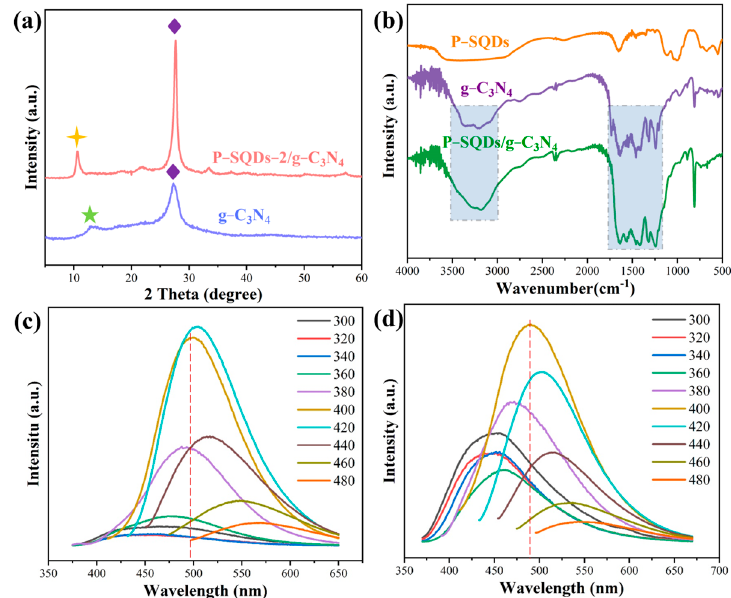
Figure 3. ( a ) XRD patterns of g-C 3 N 4 and P-SQDs/g-C 3 N 4 . ( b ) FTIR images of P-SQDs, g-C 3 N 4, and P-SQDs/g-C 3 N 4 . PL spectra of ( c ) SQDs and ( d ) P-SQDs at different excitation